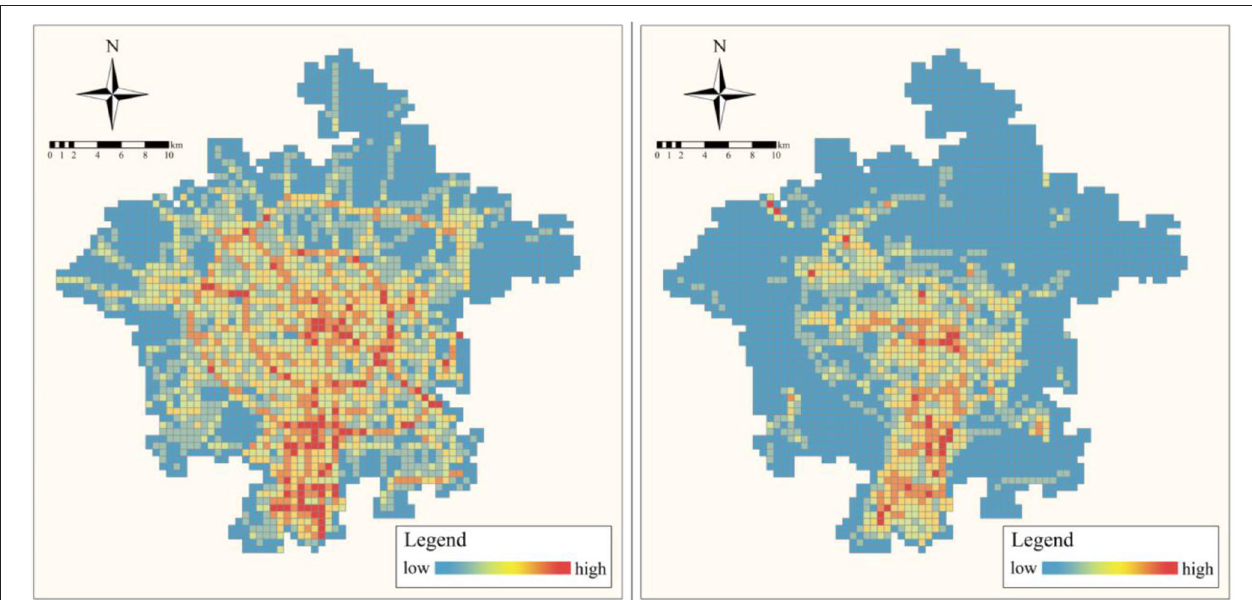
FIGURE 2 | The spatial distribution of the two indices. (A) Cycling index. (B) Running index.